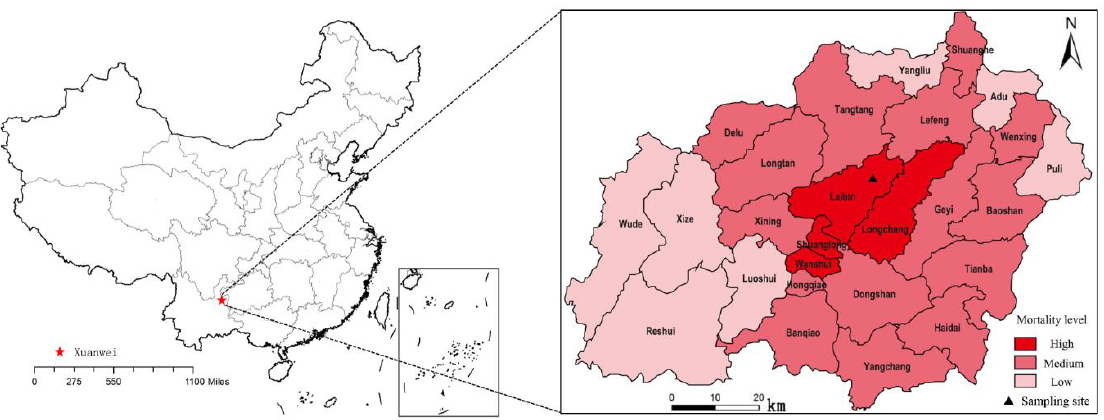
Figure 1. Map of Xuanwei showing the county-specific annual lung cancer mortality rates in 2014–2016. Raw data from Liu et al. [31].